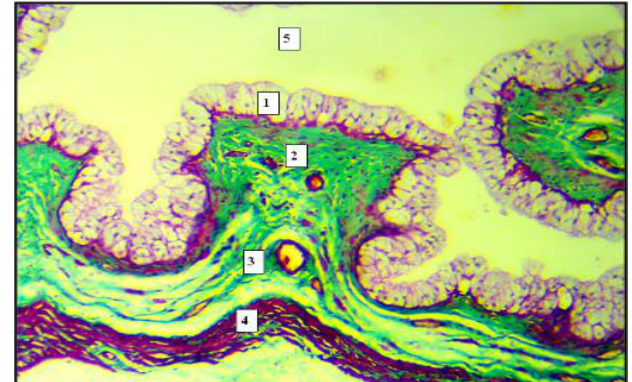
Figure 8. Vagina at its middle region showing short mucosal folds (1) covered with simple columnar mucous epithelium, propria submucosa (2), internal circular layer of tunica muscularis (3), vaginal lumen (4). 100X, Masson’s trichrome stain